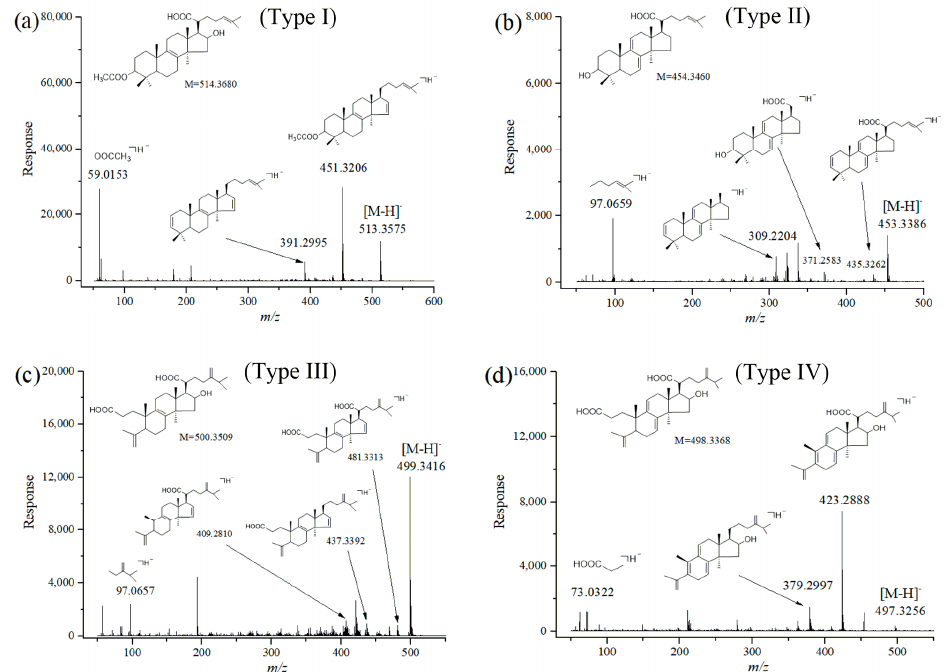
Figure 3. The MS/MS spectrum of 3- O -acetyl-16 α -hydroxytrametenolic acid ( a ), dehydrotrametenolic acid ( b ), poricoic acid H ( c ) and poricoic acid A ( d ) identified by HPLC–QTOF–MS/MS.